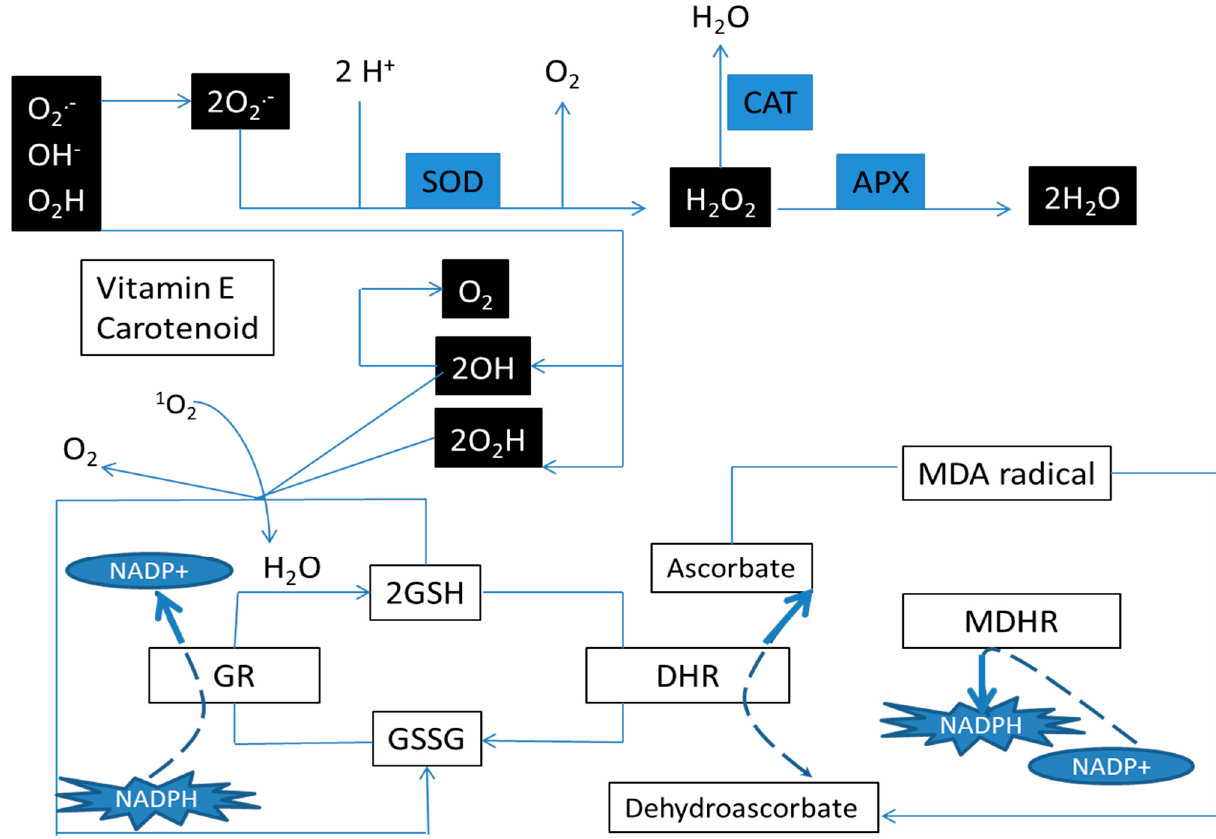
Figure 1. Enzymatic and non-enzymatic antioxidant system in plants. Enzymatic: Superoxide dismutase (SOD), catalase (CAT), ascorbate peroxidase (APX), Non-Enzymatic: oxidized glutathione (GSH), reduced (GSSG), monodehydroascorbate reductase (MDHR), dehydroascorbate reductase (DHR) and glutathione reductase (GR).